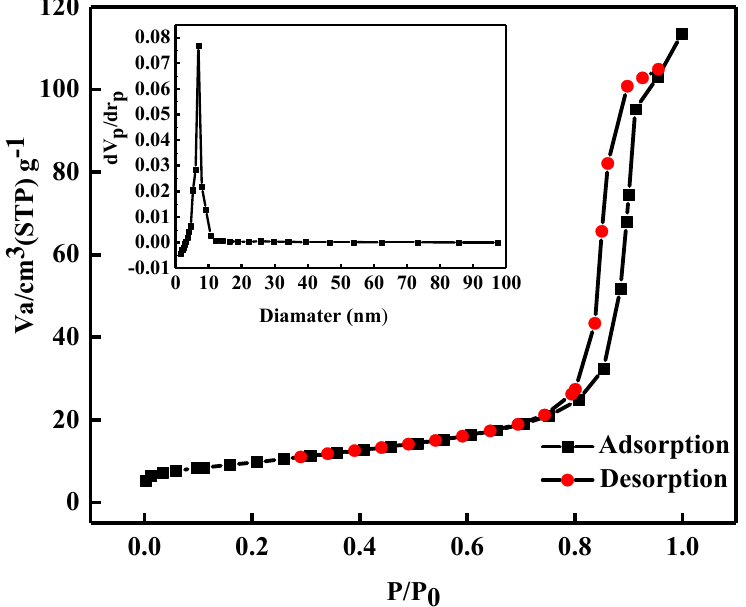
Figure 8. N 2 adsorption–desorption curve of MgO/ZrO 2 catalyst calcinated at 700 °C. Table 3. Specific surface area, average pore size, and total pore volume of the solid base